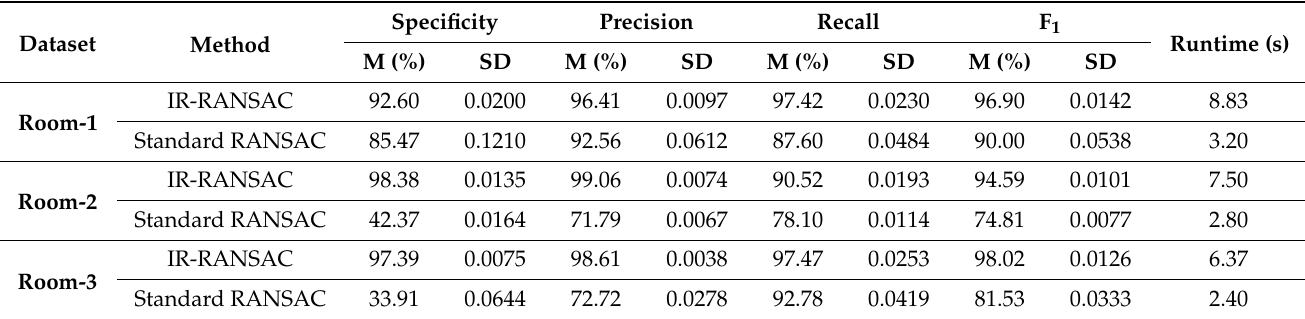
Table 5. Execution times, mean (M), and standard deviation (SD) of IR-RANSAC and standard RANSAC for specificity, precision, recall, and F 1